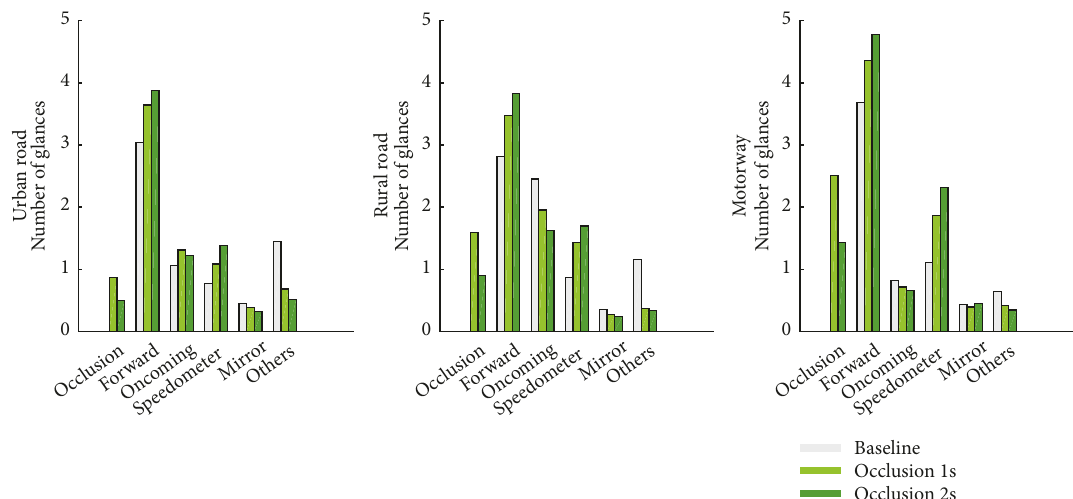
Figure 3: Number of glances towards different AOIs in three scenarios, divided by occlusion